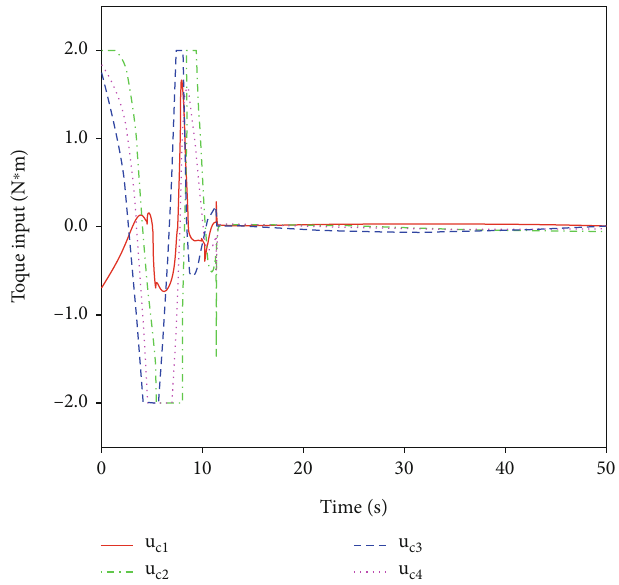
Figure 6: Time response of controlling torque in Ref. [24].